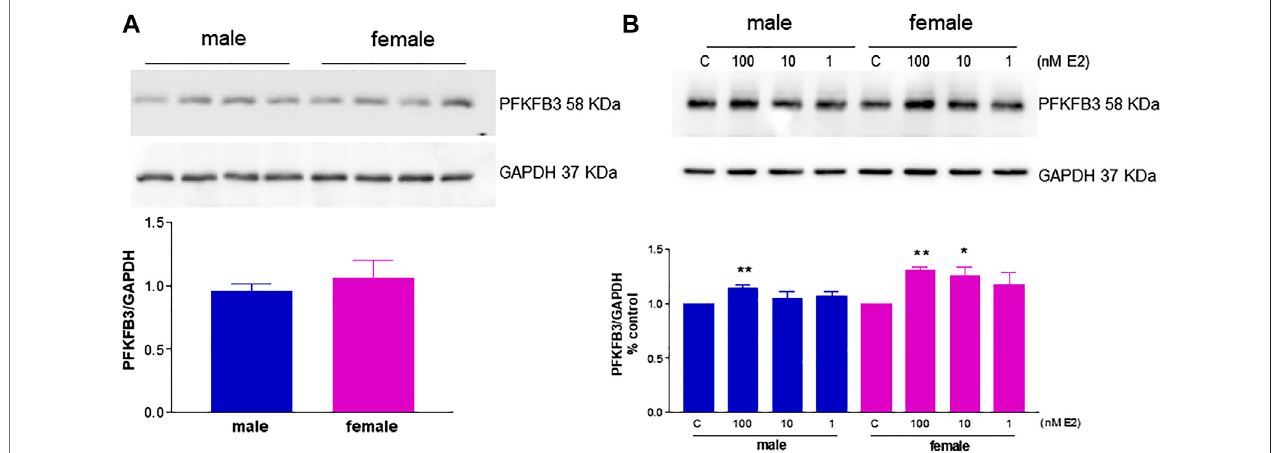
FIGURE 6 | Immunodetection of the glycolytic activator PFKFB3 in HUVECs from male and female donors in the presence or absence of E2. (A) . HUVECs were seeded in35-mm dishes in M199complete medium. Upper panel : Representative western blot showing baseline PFKFB3 immunodetection; GAPDHexpression was used asaloading control. Lowerpanel : Densitometricanalysis ofbands, normalized toGAPDHlevels.Each independentexperiment ( n (cid:1) 3)wasperformed using cells from 3 – 4 male and 3 – 4 female donors. Data are expressed as the mean ± SEM of 11 male and 11 female donors; t -test, ns. (B) . HUVECs were seeded in 35-mm dishes in M199 phenol red – free medium with 5% FBS and treated with 1 – 100 nM E2 or vehicle for 3 h. Upper panel : Representative Western blot showing PFKFB3 immunodetection; GAPDHexpression wasused asaloading control. C,control. Lower panel : Densitometricanalysisofbands, normalized toGADPHlevels.Values in